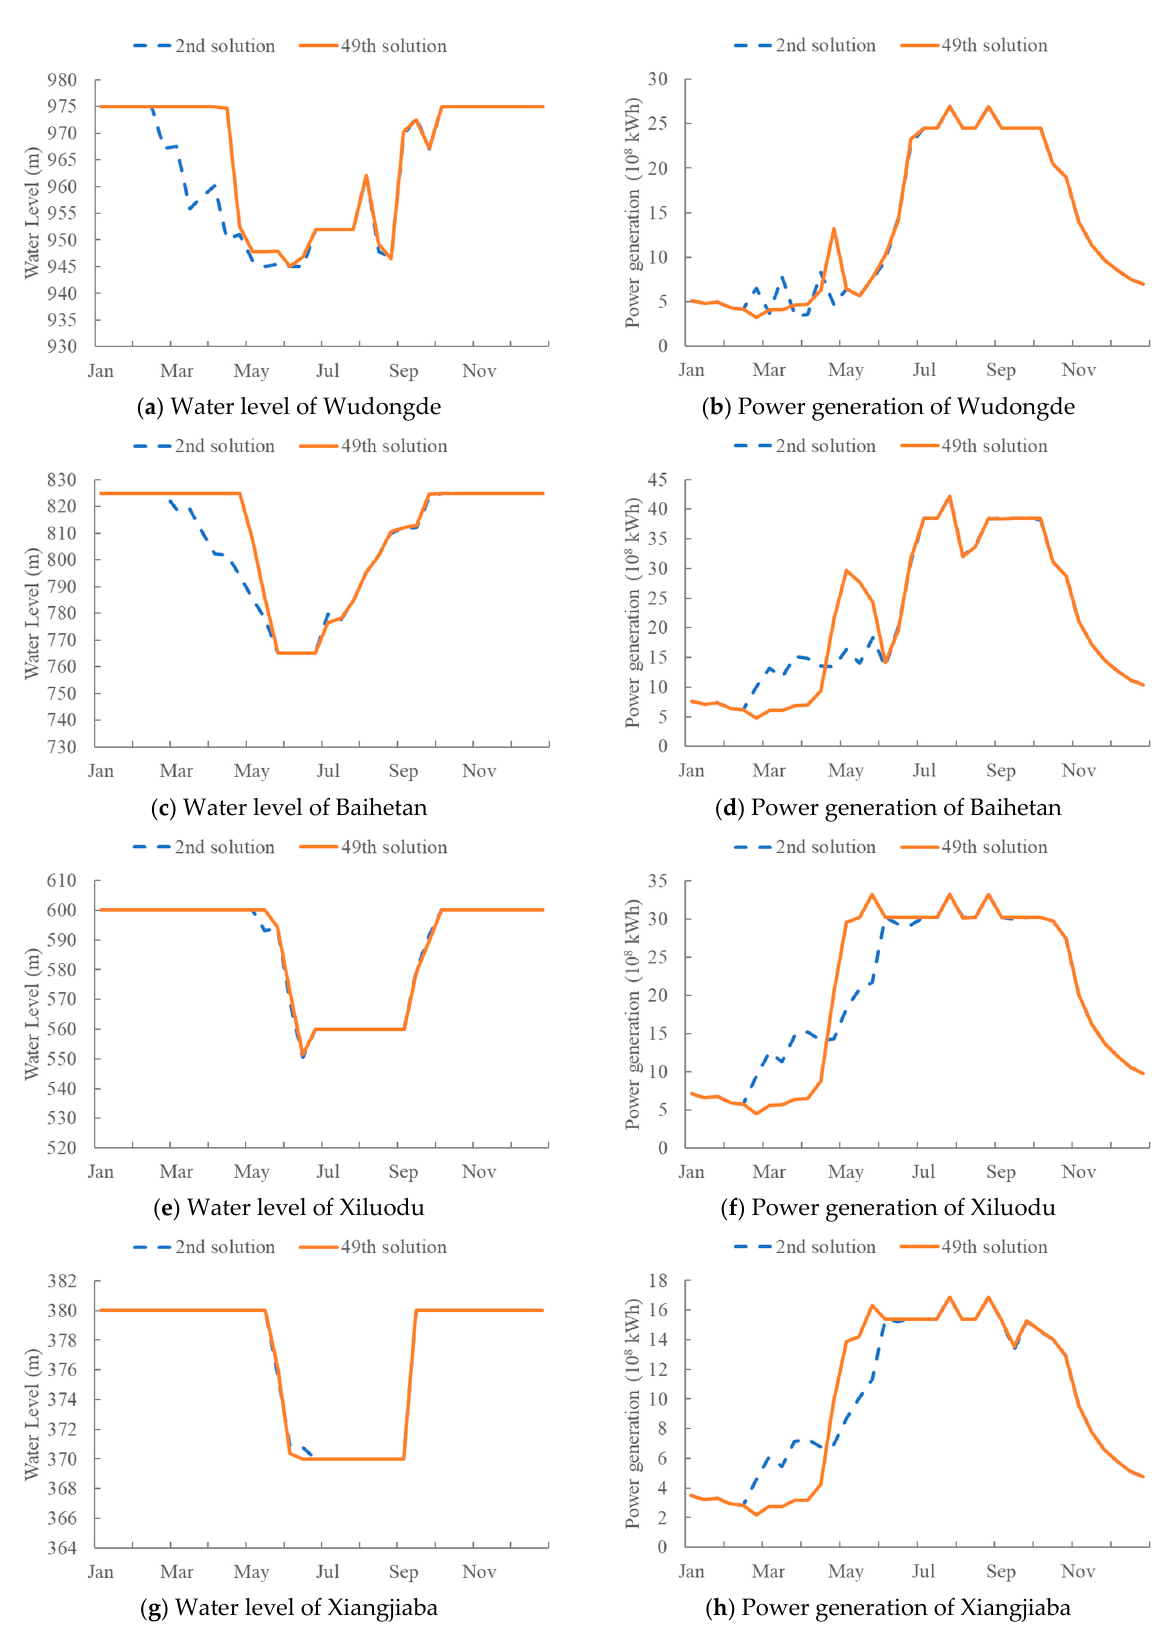
Figure 16. Comparison between the 2nd and 49th solutions in wet year. ( a ) Water level of Wudongde ( b ) Power generation of Wudongde ( c ) Water level of Baihetan ( d ) Power generation of Baihetan ( e ) Water level of Xiluodu ( f ) Power generation of Xiluodu ( g ) Water level of Xiangjiaba ( h ) Power generation of